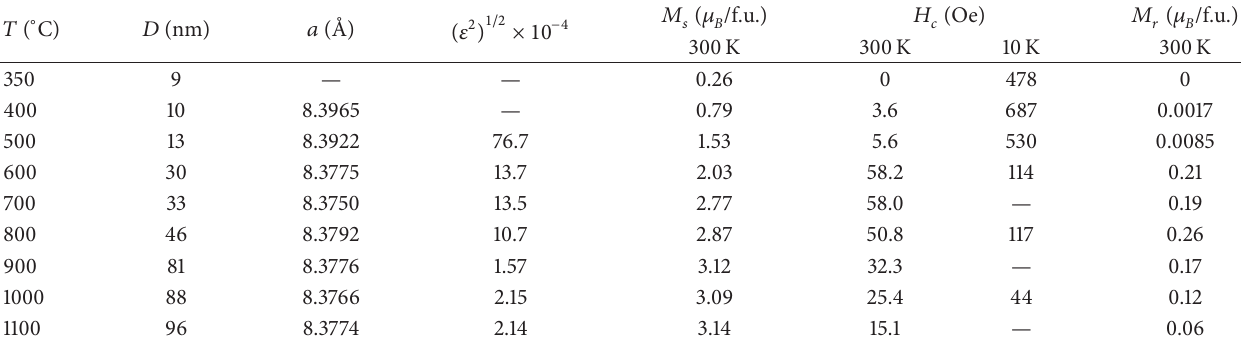
Zn Fe O ferrites from 350 to 1100 ∘ 0.5 0.5 2 4